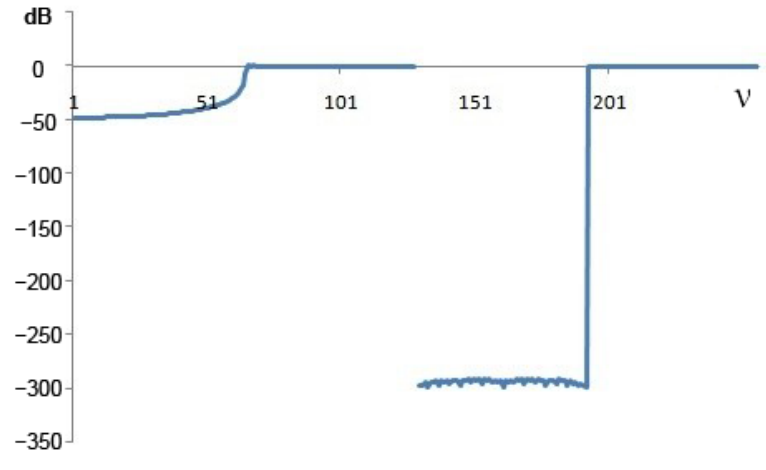
Figure 7. Frequency response.